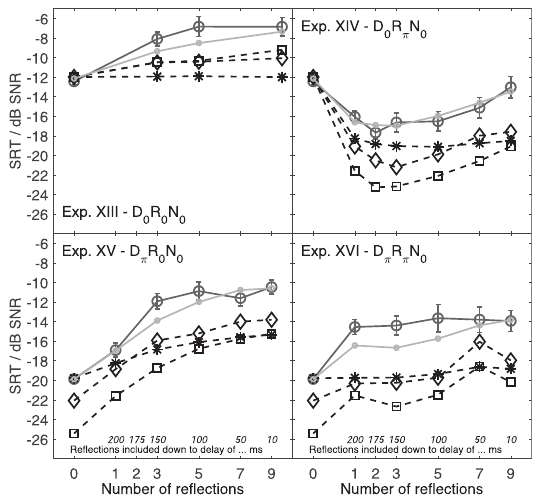
Figure 6. Measured and predicted SRTs for experiments XIII to XVI displayed as in Figure 3. This fi gure shows the in fl uence of multiple re fl ections of the target speech, which were varied in their increasing number of re fl ections at different delays, starting from late re fl ections. IPDs were set as indicated. Note that the fi rst condition is always direct sound